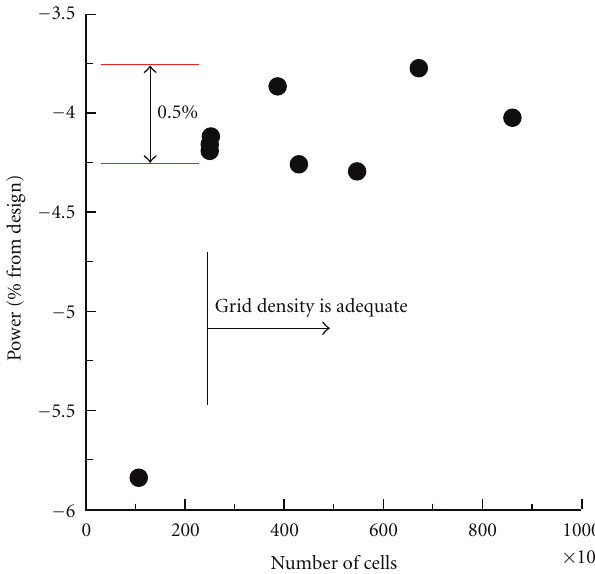
Figure 6: Grid density calculations using impeller B#2.